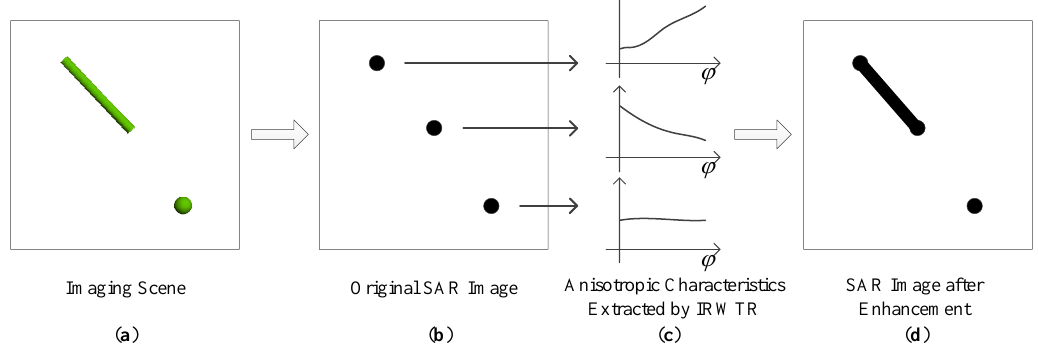
Figure 4. Diagram of the proposed method. ( a ) The scene for imaging. ( b ) SAR imaging result. ( c ) Estimated anisotropic characteristics. ( d ) Enhanced SAR imaging result.